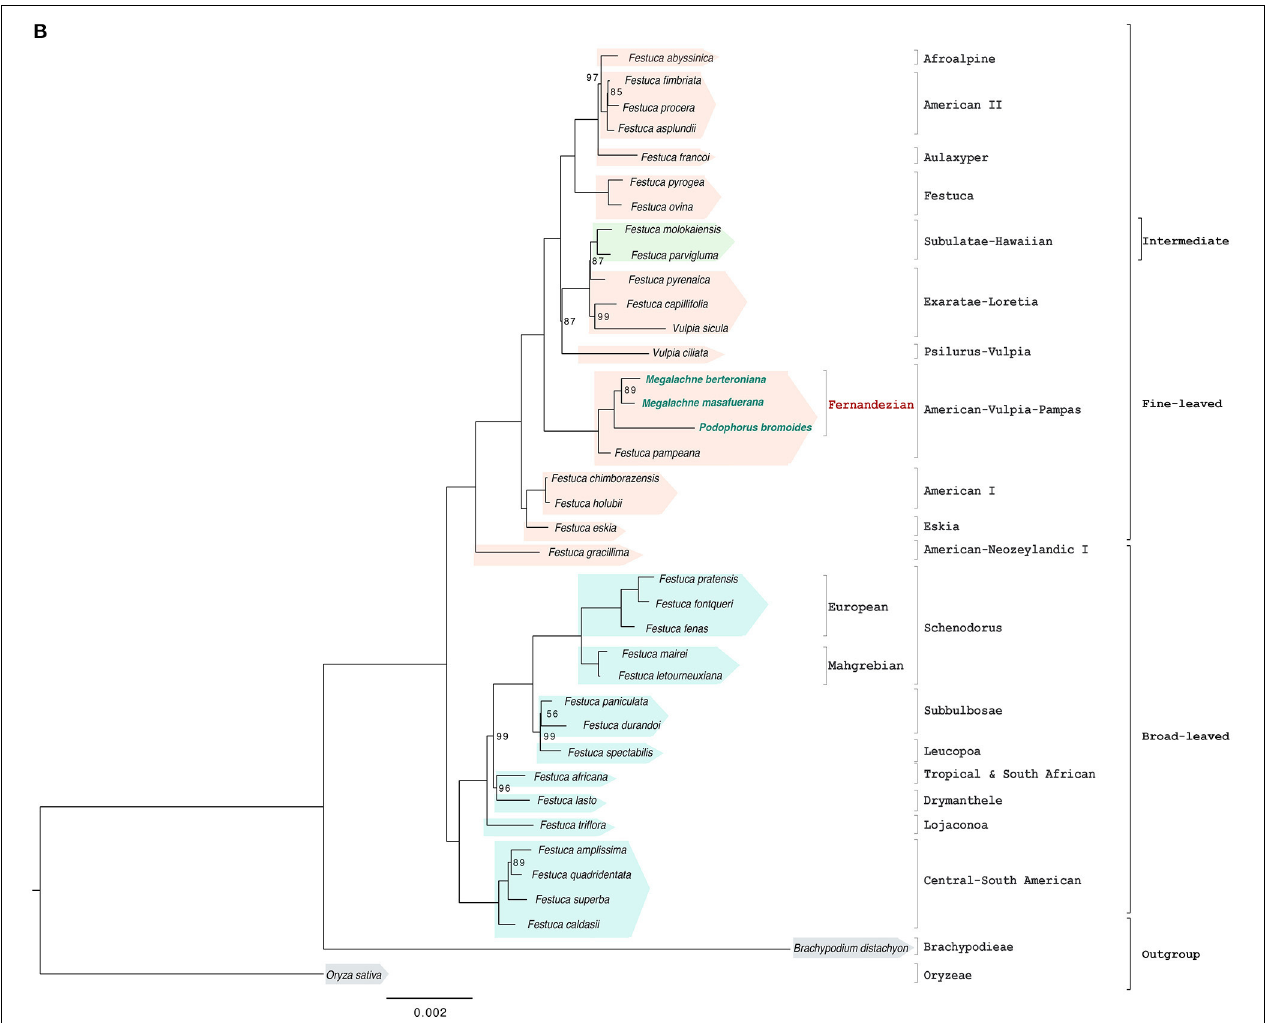
FIGURE 2 | Maximum likelihood full plastome (A) and reduced plastome (B) trees constructed with IQTREE showing the relationships among the studied Fernandezian and Loliinae grasses. Oryza sativa was used to root the trees. Numbers indicate branches with UltraFast Bootstrap supports (BS) < 100%; the remaining branches have 100% BS